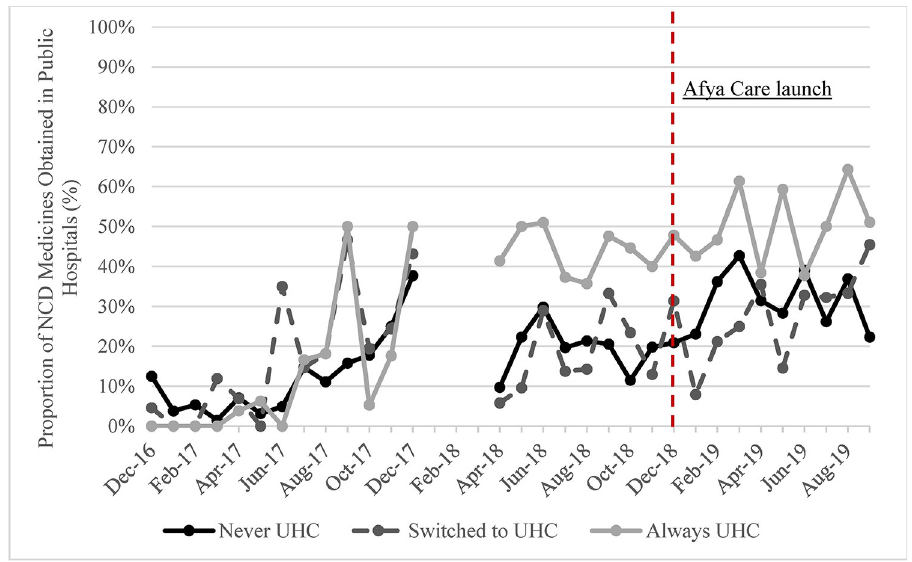
Fig 4. Proportion of NCD medicines obtained in public hospitals by UHC.